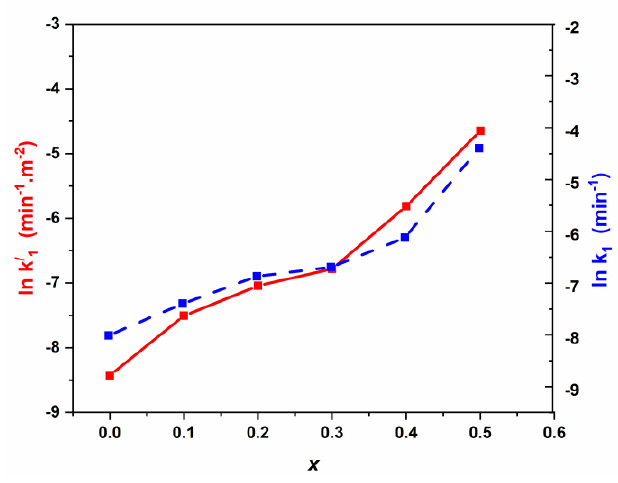
Figure 8. Variation of ln k1 and lnk1’ vs. cadmium coordination in NSFs.